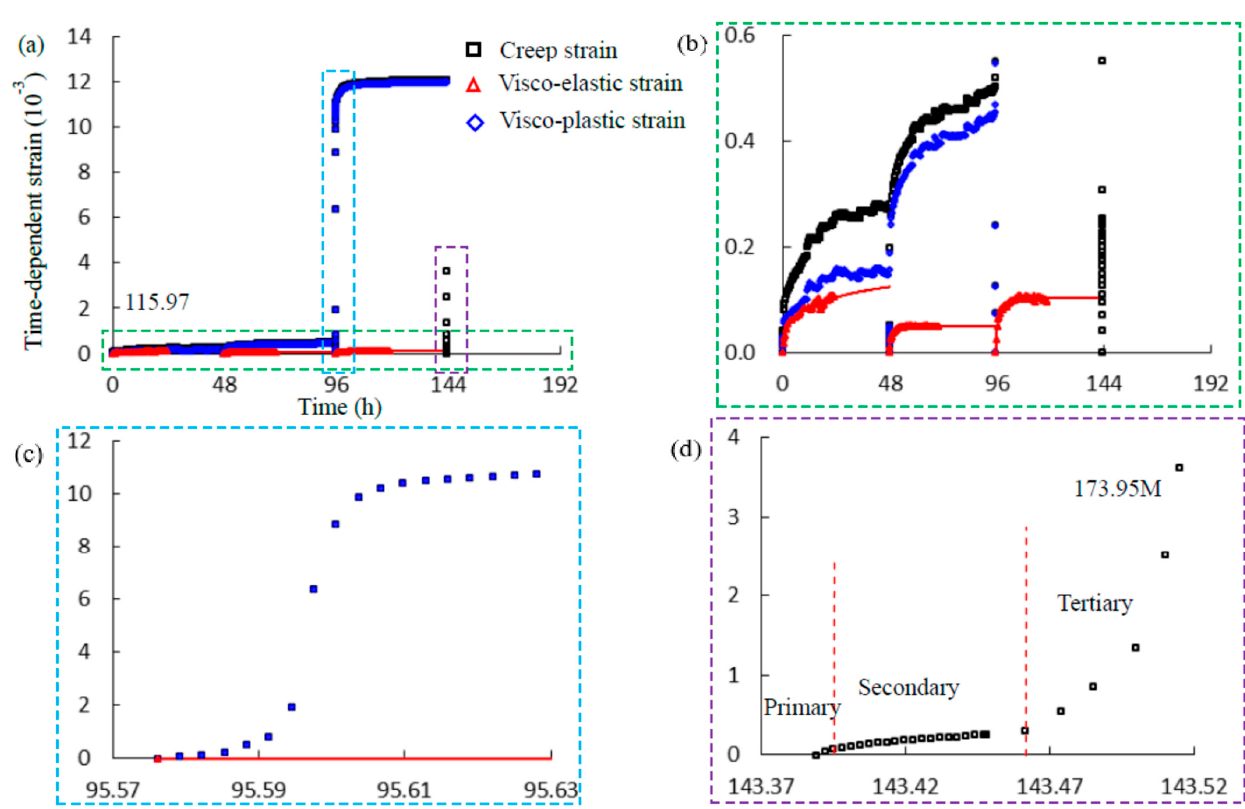
Figure 11. Relationships between stress ratio with steady-state strain ratio and damage after dif- ferent temperature treatment.